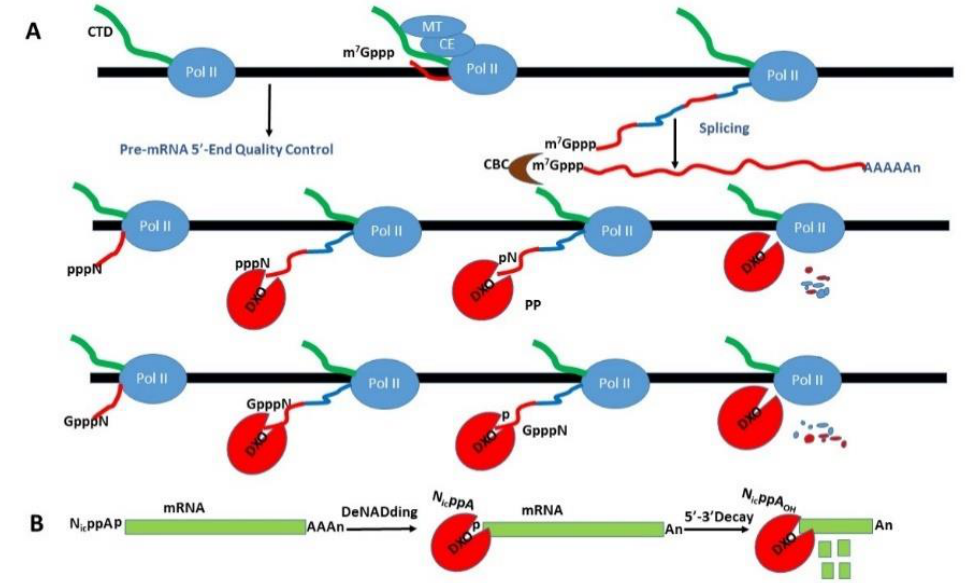
Figure 4. DXO decapping and DXO-mediated decay of NAD + -capped mRNA. ( A ) DXO can remove the diphosphate from a triphosphorylated cap of mRNA, the entire cap structure of an unmethylated guanosine-capped mRNA, or aberrant pre-mRNAs. ( B ) DXO hydrolyzes the phosphodiester linkage 3′ to the adenosine to remove the entire NAD + moiety and generates an RNA molecule with 5′ monophosphate. Modified and redrawn from ref [89] for panel A, and ref [91] for panel B (with permission from Dr. Mike Kiledjian, Rutgers University, NJ).